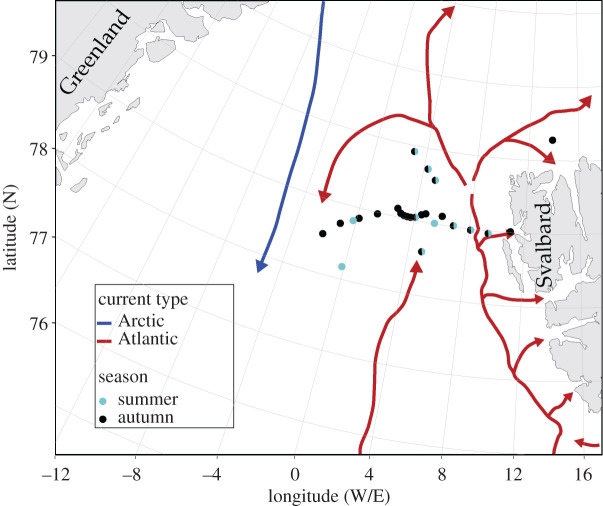
Map of stations within the Fram Strait in the proximity of the LTER observatory HAUSGARTEN. The samples during summer were collected with the RV Polarstern on board cruise PS114 from 16 July to 23 July 2018 and during autumn with the RV Maria S. Merian on board MSM77 from 16 September to 4 October 2018. Warm-water with Atlantic-origin (red arrows/northward) enters via the West Spitsbergen Current (WSC) in the eastern Fram Strait and cold polar water of Arctic-origin (blue arrows/southward) exits via East Greenland Current (EGC) in the west of the Fram Strait. (Online version in colour.)